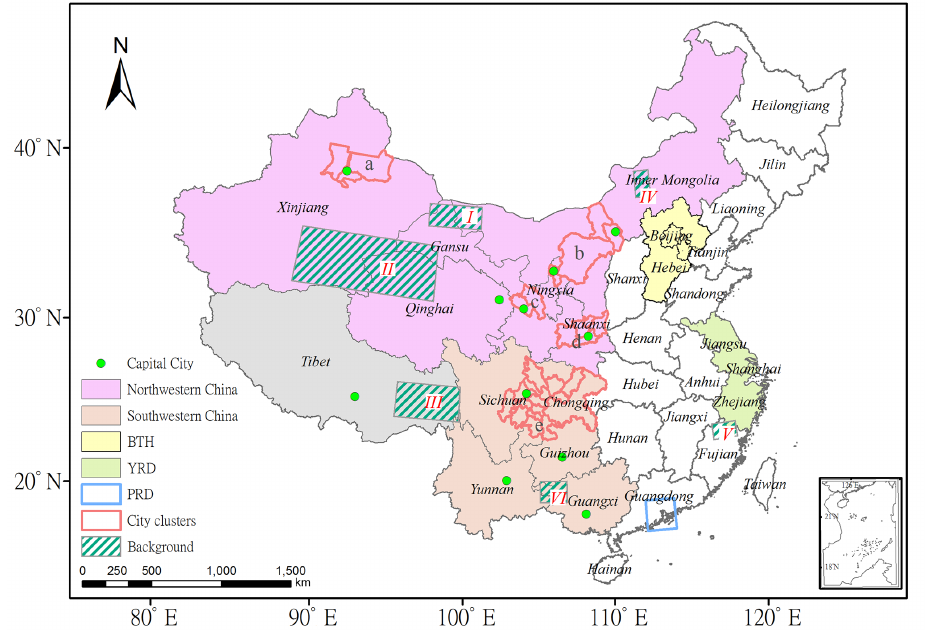
Figure 1. The study regions. Several city clusters are also identified: (a) Urumqi city cluster, (b) Inner Mongolia industrial city cluster, (c) Gansu–Ningxia, (d) Shaanxi–Guanzhong, and (e) Chengdu–Chongqing.